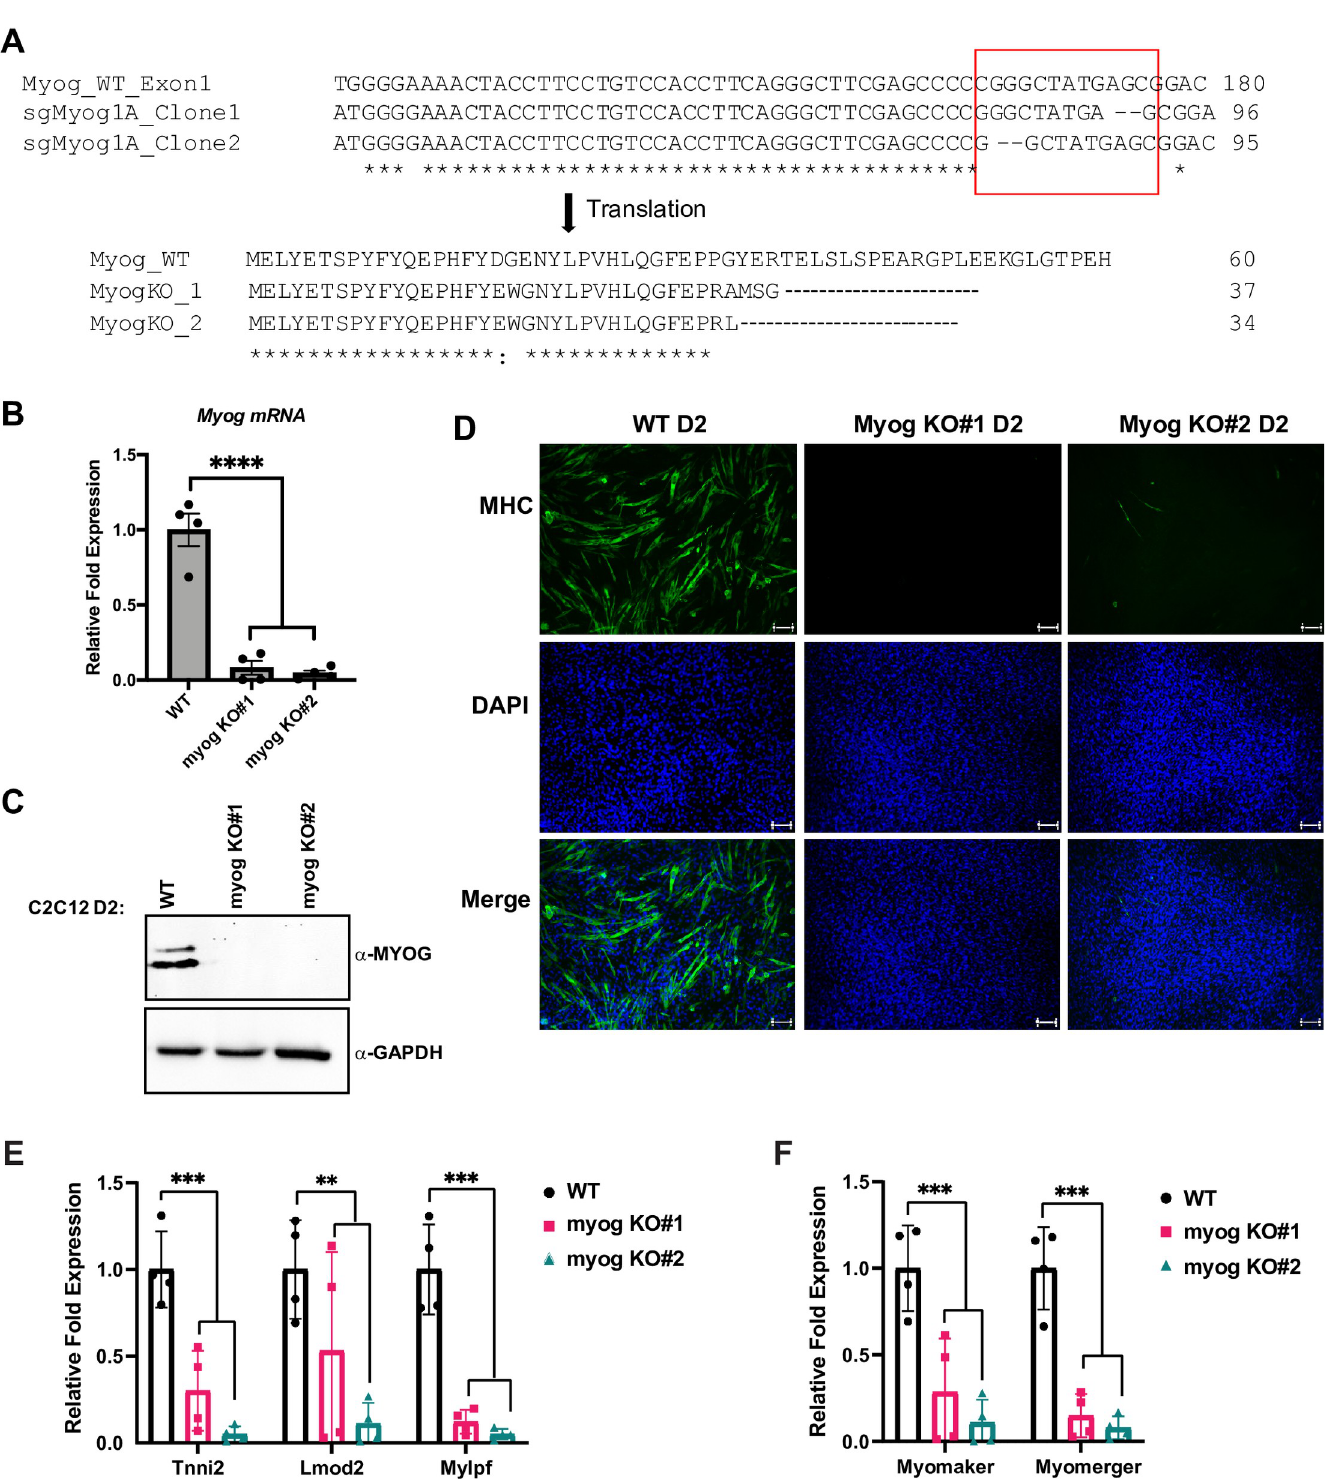
Fig 4. Deletion of Myog impairs muscle differentiation in skeletal muscle. A. C2C12 cells stably expressing plasmid containing single guide RNA sequence designed against exon-1 of the myogenin gene and Cas9 protein were selected, and individual clones were propagated. The Myog deletion clones were confirmed by sequencing. The sequences were aligned using Clustal Omega tool with default settings and the indel region is indicated in a red box. B-C. Cells used in A were grown in differentiation condition for two days (D2) and were assayed for the expression of Myog at both mRNA (B) and protein (C) by qRT-PCR and western blot, respectively. GAPDH was used as a loading control. Standard errors (S.E.) from the mean (Mean ± S.E.) represents the error bars. (Student t.test; ���� p < 0.0001, n = 4 biological